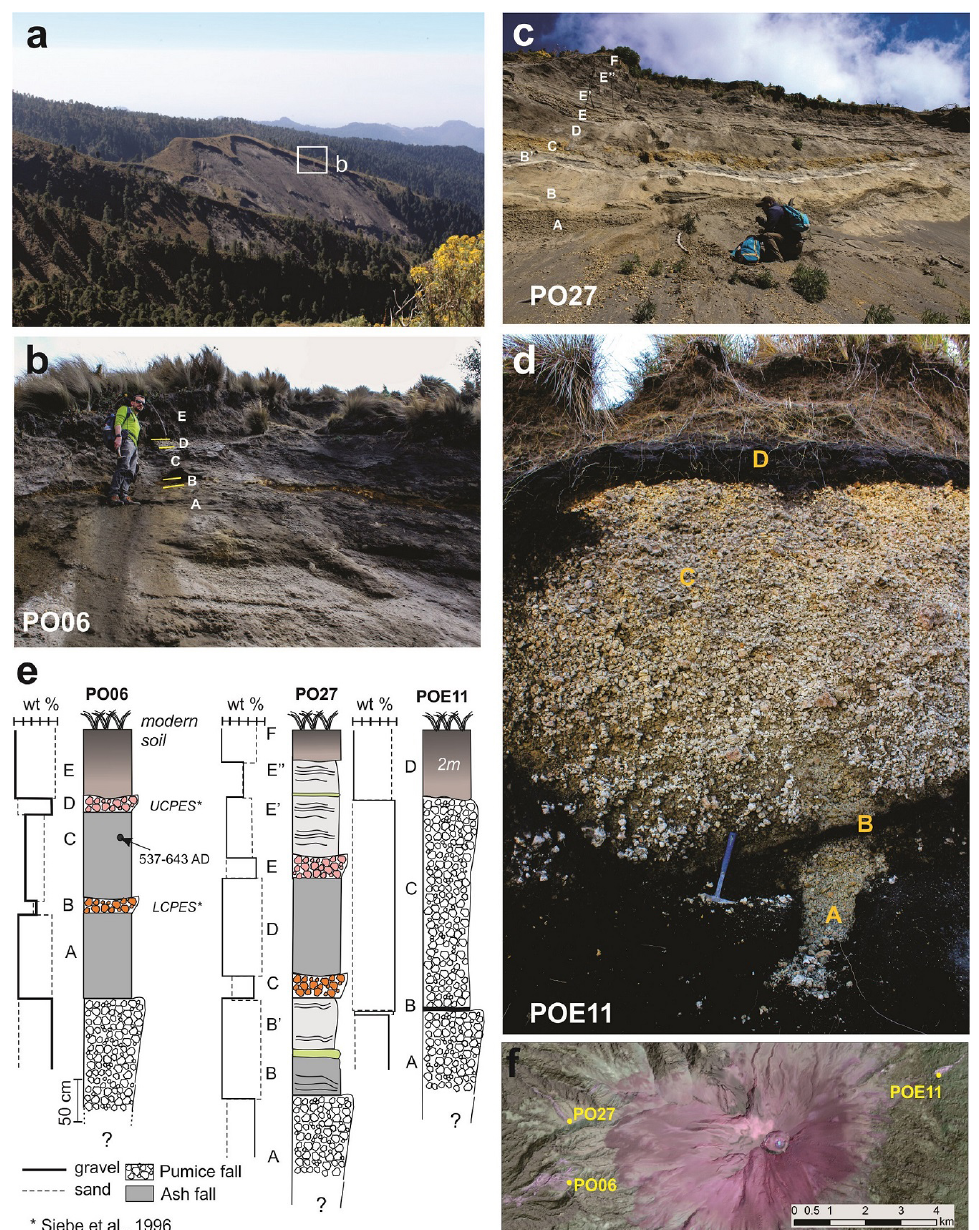
Figure 6. View of the three main landslides scarps: (a, b) Huitzilac, (c) Hueyatlaco, (d) Xalipilcayatl. In panel (e) the stratigraphic sections of the scarps and the grain size distributions of their strata (data in Appendix A) are reported; upper classic Plinian eruptions (UCPES, pink), lower classic Plinian eruptions (LCPES, orange), and the dated layer are indicated; see text for more details. (f) Geographic location of sampling points; background image: Pléiades 1A image acquired on 13 November